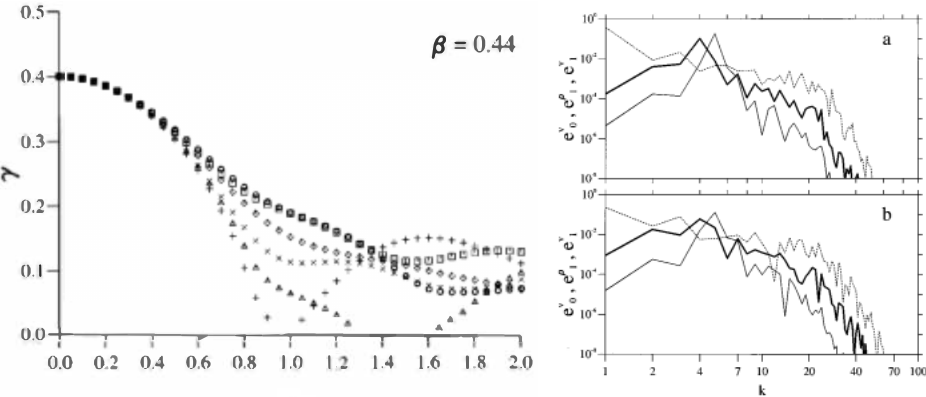
Figure 7. Composite figure that reproduces Figures 1 and 3. of Malara and Velli (1996) [22]. Left panel : the largest growth rate corresponding to the case k 0 = 4, B ( 0 ) / B 0 = 0.5 and β = 0.444 is plotted as a function of a ; different curves correspond to different choices of the numbers { δ n } . Right panels : the Fourier spectra of velocity associated with the pump wave (boldface continuous lines), with the daughter wave (dashed lines) and of the density fluctuation (thin lines), for a = 0.25 ( panel a ) and for a = 0.5 ( panel b ). Courtesy of AIP Publishing. Permission to reprint